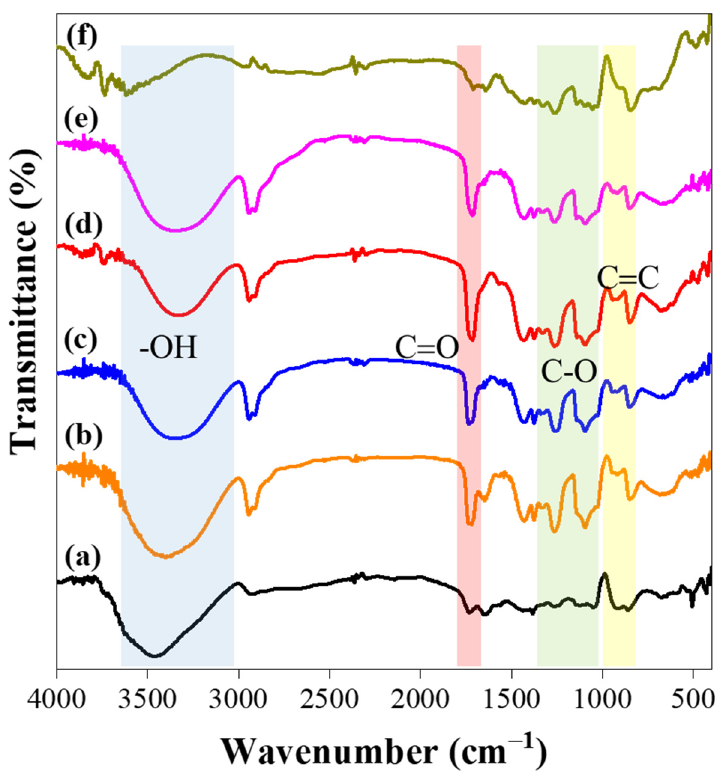
Figure 1. FTIR spectra of PVA ( a ) and cPVA at 100 °C ( b ), 120 °C ( c ), 140 °C ( d ), 160 °C ( e ), and 180 °C ( f ).